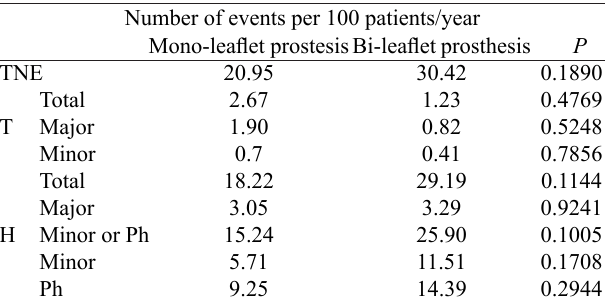
Table 1. Number of events per year patients/year. Data obtained by the inclusion of all patients in the